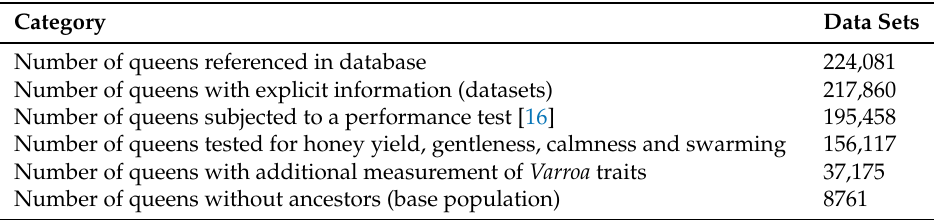
Table 1. Overview over datasets as of 14 February 2020, date of data closure.